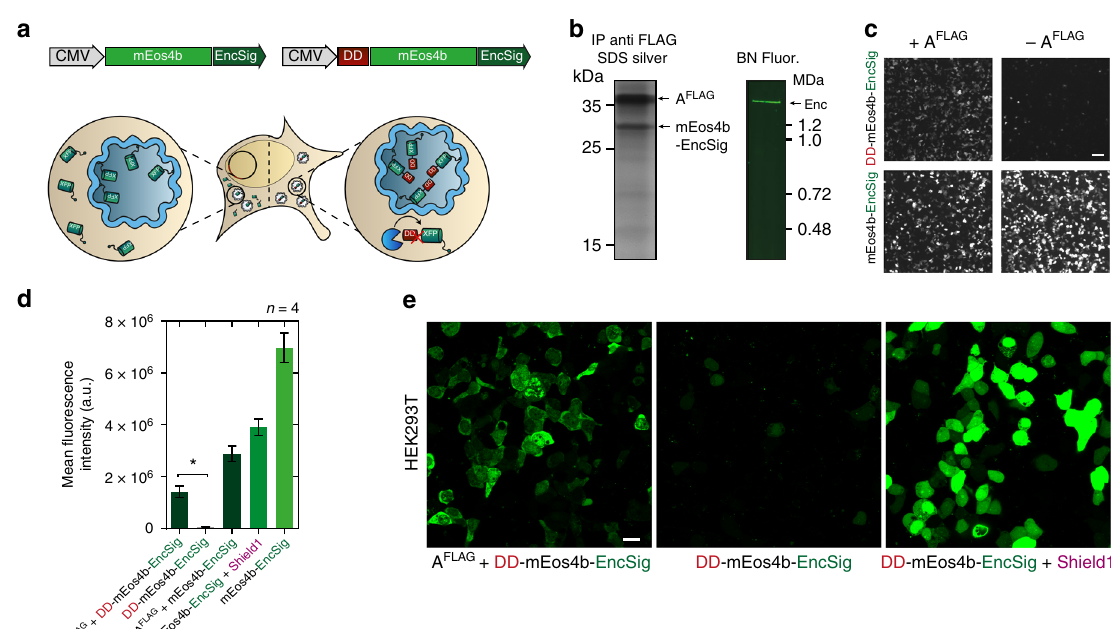
Fig. 3 Selective degradation of non-encapsulated cargo. a Schematic of genetic construct showing a minimal C-terminal encapsulation signal (EncSig) fused to the photoactivatable fl uorescent protein mEos4b (mEos4b-EncSig) to associate it to the inner surface of the nanocompartment. When mEos4b-EncSig is N-terminally fused to an FKBP12-derived destabilizing domain (DD), it is degraded by the proteasome unless it is sequestered into the encapsulin shell. This strategy thus selectively enriches cargo inside the lumen of the nanocompartment. b Cargo loading of mEos4b-EncSig into the nanocompartment composed of A FLAG was demonstrated by co-immunoprecipitation (Co-IP) against the FLAG epitope followed by silver-stained SDS-PAGE (left panel). Corresponding analysis of whole cell lysate by BN-PAGE on a UV imager shows fl uorescence of the native encapsulin band indicating the presence of the mEos4b-EncSig cargo. c Representative 2 × 2 table of epi fl uorescence microscopy images from HEK293T cells co-expressing DD-mEos4b-EncSig with or without A FLAG (upper row) compared to coexpression of the cargo without destabilizing domain (mEos4b-EncSig, lower row). Scale bar represents 50 µ m. d Corresponding quanti fi cation of the fl uorescence intensities as exempli fi ed in c . Co-expression of A FLAG signi fi cantly protects degradation of DD- mEos4b-EncSig ( p = 0.0286, Mann – Whitney test, n = 4 biological replicates, error bars represent mean ± SEM). DD-mEos4b-EncSig can also be stabilized by adding the small molecule Shield1 (0.5 mM, magenta label) to the cell culture medium. e Confocal microscopy images of HEK293T expressing DD- mEos4b-EncSig with or without A FLAG . As a reference DD-mEos4b-EncSig was stabilized via the addition of 0.5 mM Shield1. Please note that the contrast of all images was linearly adjusted to the same extent optimizing for the condition shown on the left, which resulted in partial oversaturation of the condition shown on the right. Scale bar represents 20 µ